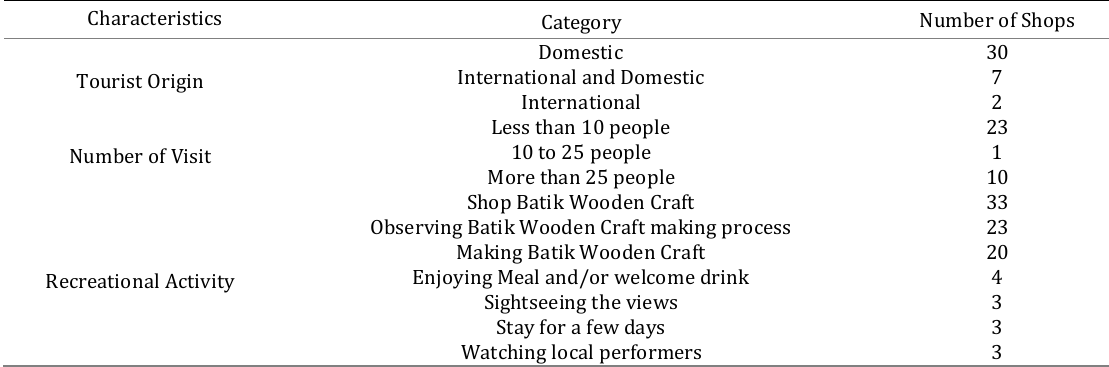
Table 5 Visitors in Krebet Tourism